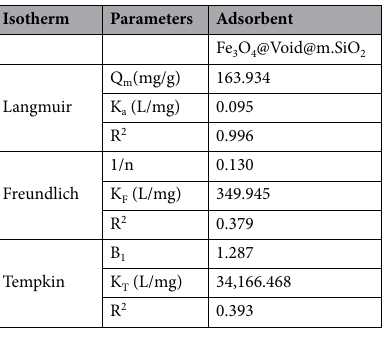
Table 2. Isotherm parameters and R 2 amounts obtained for the MB adsorption using Fe 3 O 4 @Void@m.SiO 2 .